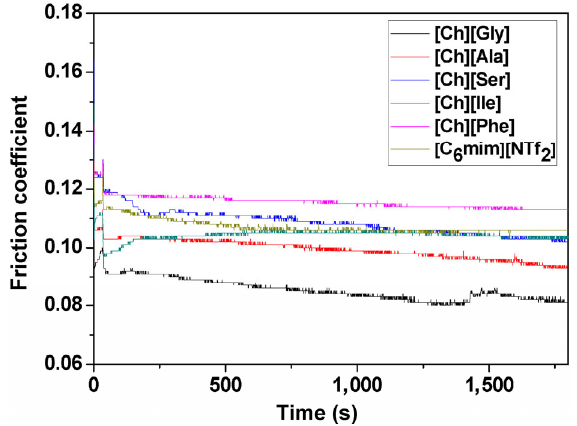
Fig. 4 Evolution of the friction coefficients of the system lubricated with [Ch][AA] ILs and [C 6 mim][NTf 2 ].